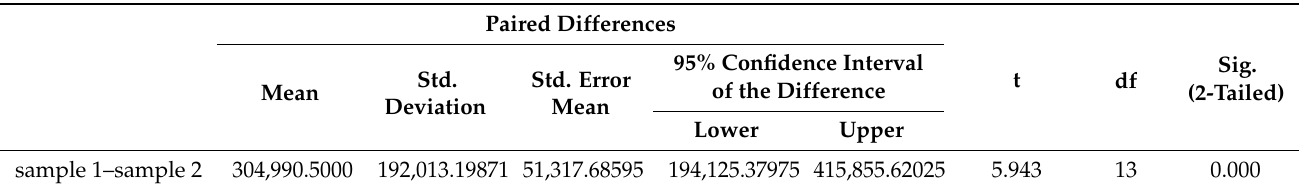
Table 1. Paired T test. (Std. is an abbreviation of Standard. Df means degree of freedom. Sig. is an abbreviation of